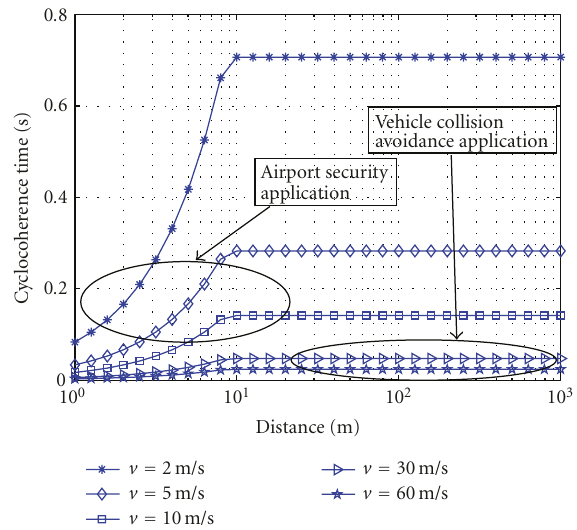
Figure 9: Cyclostationarity coherence time for di ff erent applica- tions, single